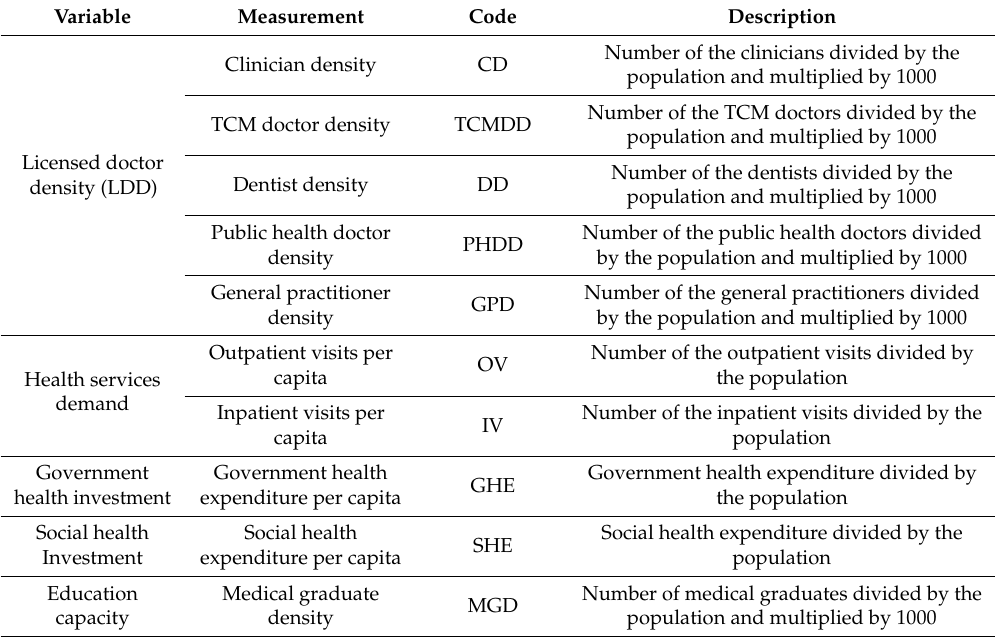
Table 1. Variable measurements, codes, and descriptions.